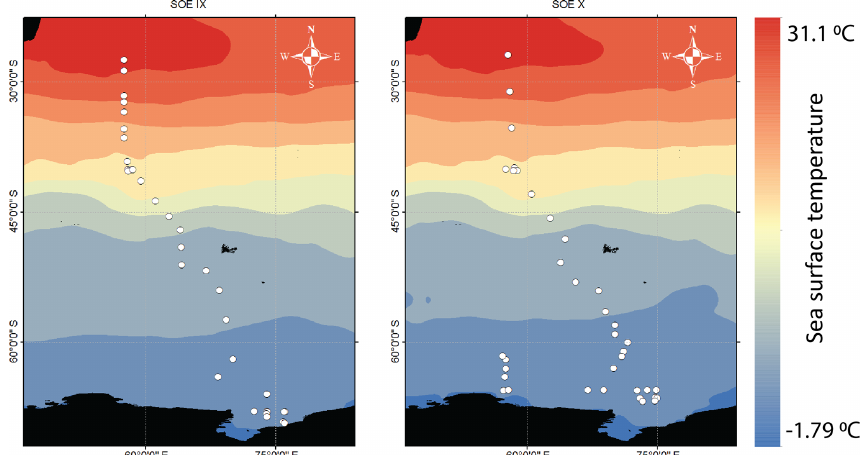
Figure 1. The water vapor sampling locations during the two expeditions – January 2017 (SOE-IX) and December 2017 to January 2018 (SOE-X) – shown as open circles overlain on the map of mean monthly sea surface temperature during the two expeditions. The sea surface temperature data are from the Reanalysis R-2 dataset (Kanamitsu et al., 2002).